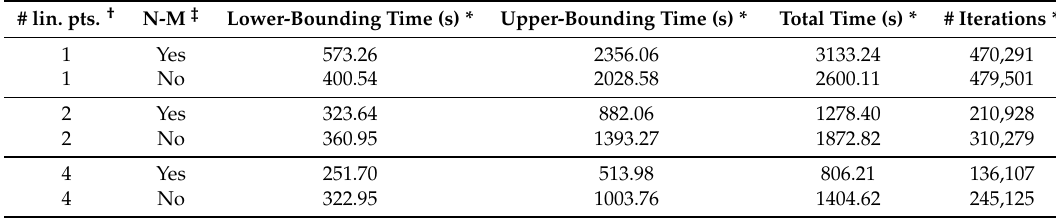
Table 5. The solution statistics for our implementation when applied to (10).